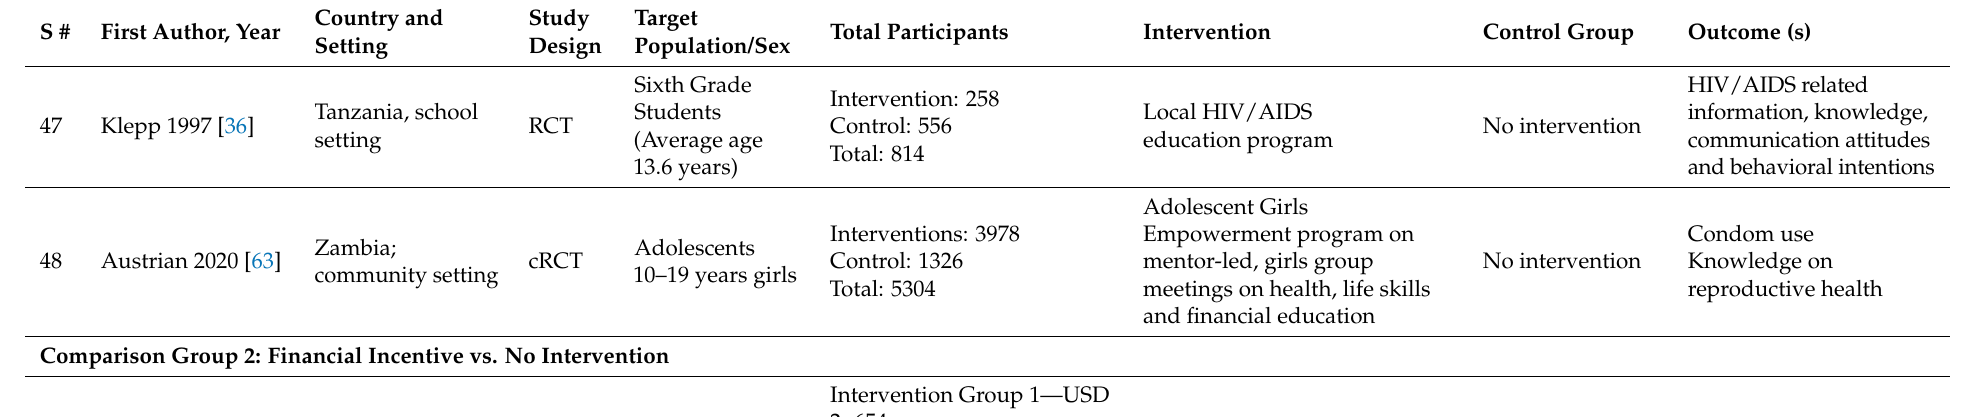
Comparison Group 2: Financial Incentive vs. No Intervention